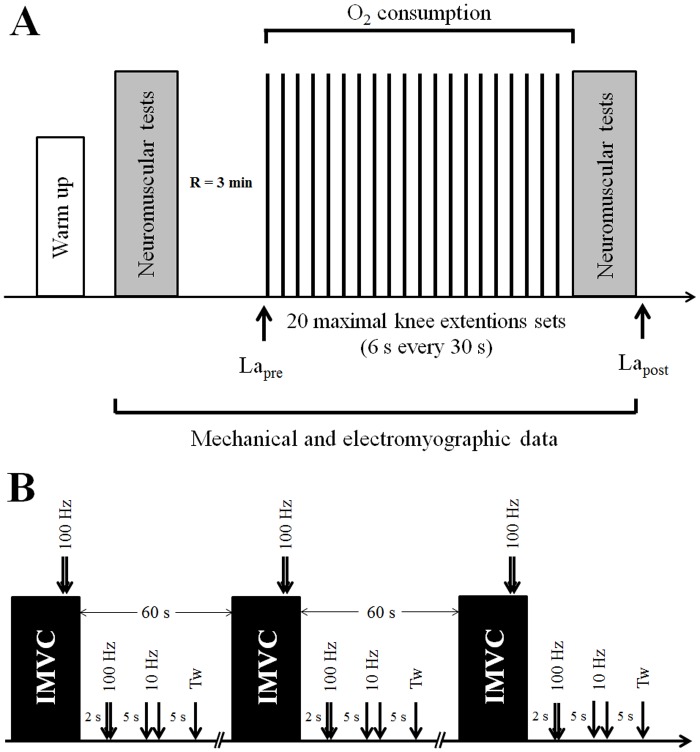
Experimental design (A) and neuromuscular testing procedure (B).Arrows indicate the timing of (A) blood micro sampling for lactate analysis (Lapre and Lapost) and (B) motor nerve stimulation. Three types of stimulation were performed: doublet stimulation at 100 Hz, doublet stimulation at 10 Hz and single twitch (Tw). Stimulations were delivered during the isometric maximal voluntary contraction (IMVC) and on the relaxed potentiated muscle (baseline).